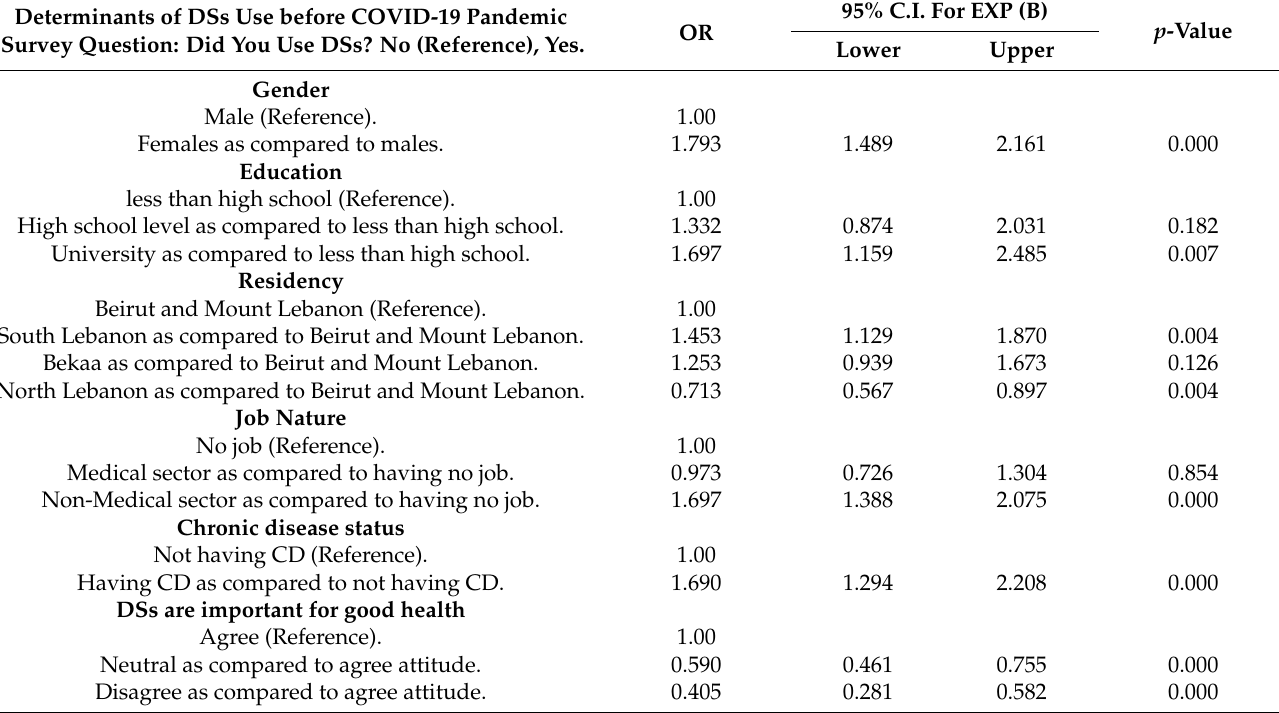
Table 3. Regression analysis, Backward LR Odds Ratio (Model